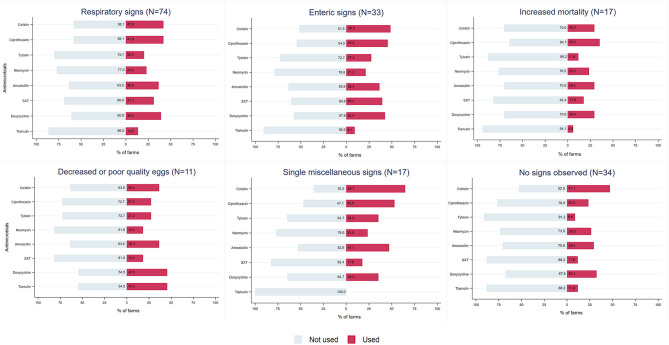
Types of antimicrobial used (percent usage) by commercial layer and broiler farmers in Chattogram, Bangladesh, for clinical signs reported on these farms. Usage relates to the application of antimicrobials in the current production cycle at the time of the survey in 2019 (mean age of layers: 334 days, mean age of broilers: 19 days). Most frequently used antimicrobials are presented here, representing 71.5% of overall usage.